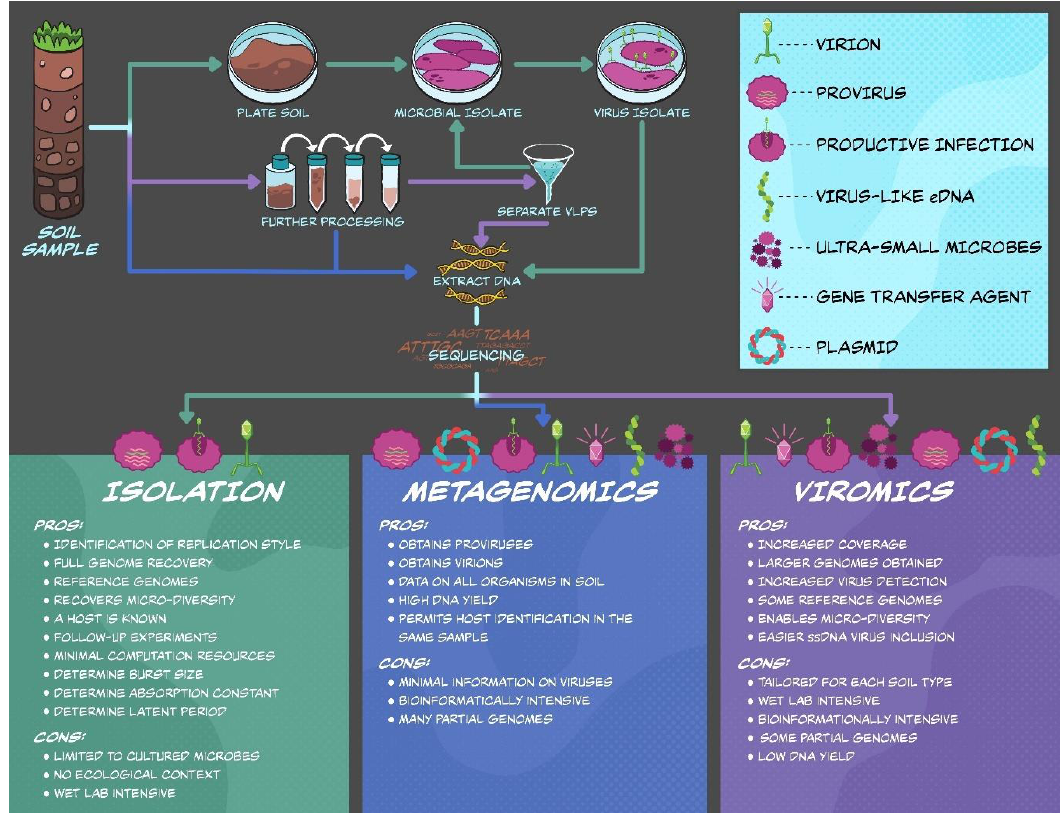
Figure 2. Overview of three common methods of virus characterization. Major methodological steps using virus-isolation (green), metagenomic (blue), and viromic (purple) approaches are shown. Possible contaminants, which are entities that may be described as viruses but which are not actually viruses, are denoted with icons for each approach (as summarized in Section 4). The icons are listed from left to right in order of potential prevalence in each method, although the order will depend on the sample and how it is treated. Finally, the pros and cons are listed for each approach. The pros for viromes are as relative to metagenomes.